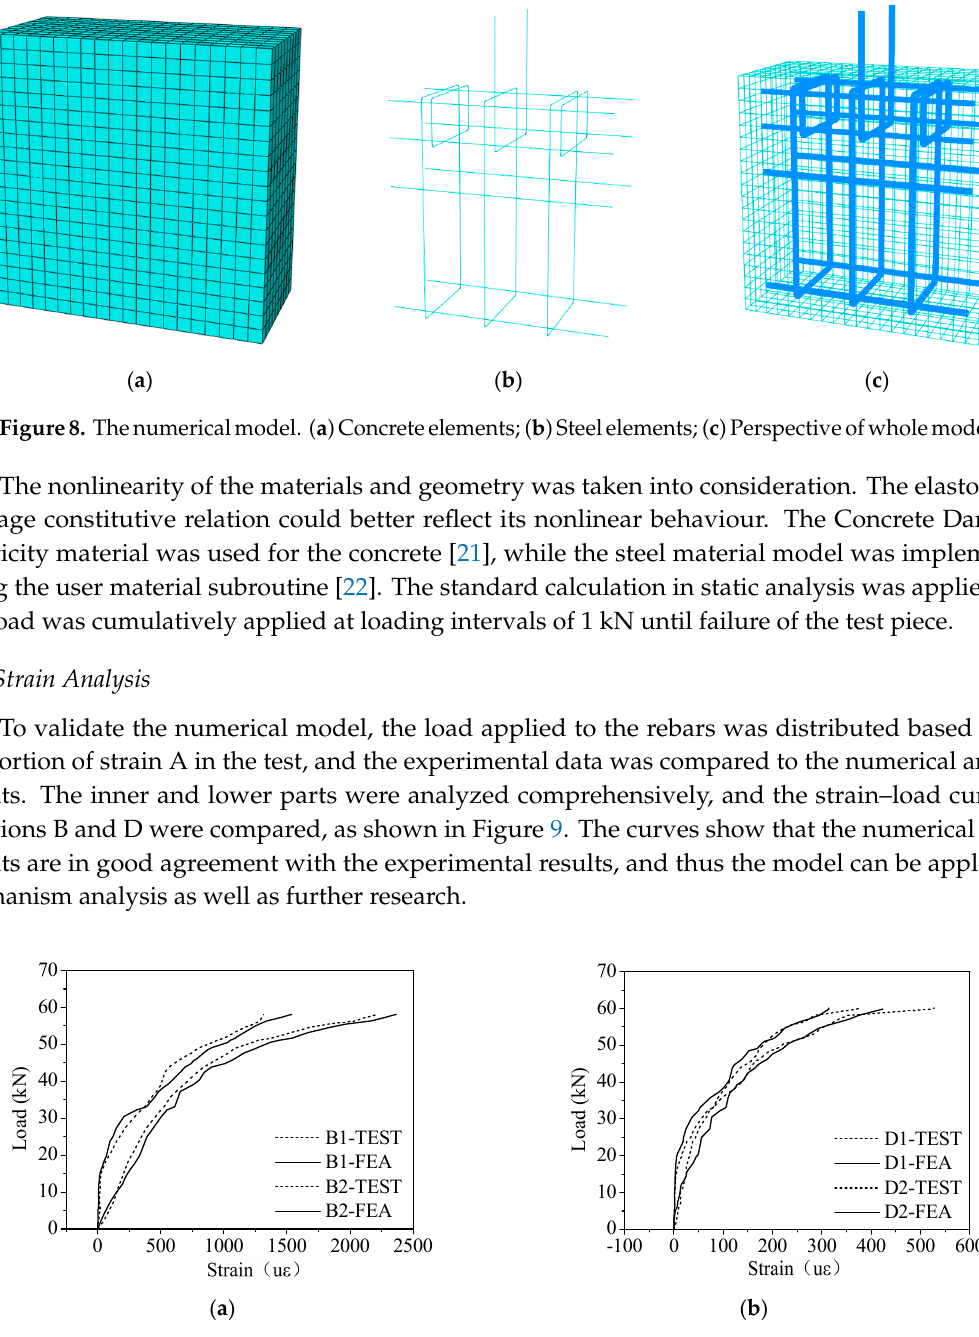
Figure 9. Verification of the numerical results for the strain values. ( a ) Strain curves at B1 and B2; ( b ) Strain curves at D1 and D2.